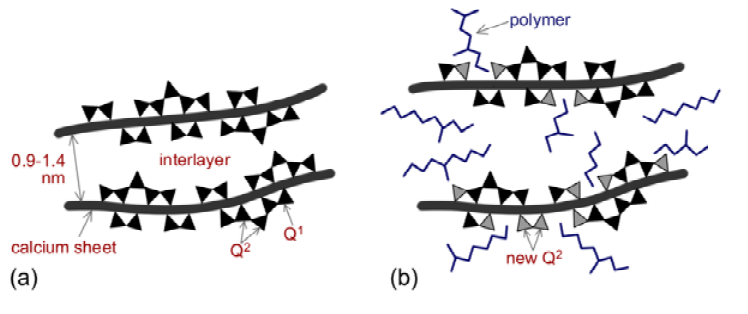
Figure 3. Schematic of polymer-modified C-S-H nanostructure. a: the nanostructure of pristine C-S-H. b: The nanostructure of modified C-S-H after the interaction with polymer